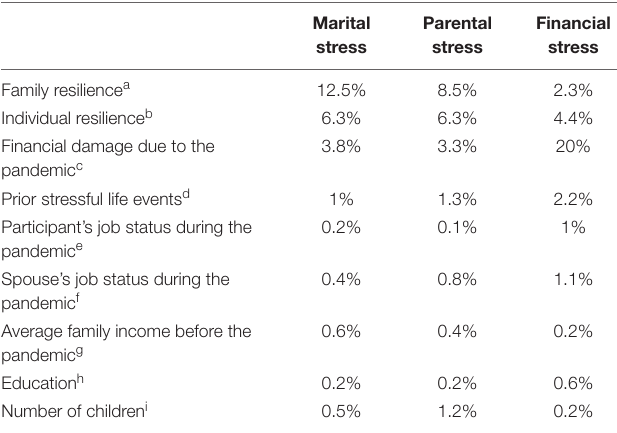
TABLE 5 | Summary of dominance analysis results: means of prediction variance for each dependent variable ( N = 477 ).